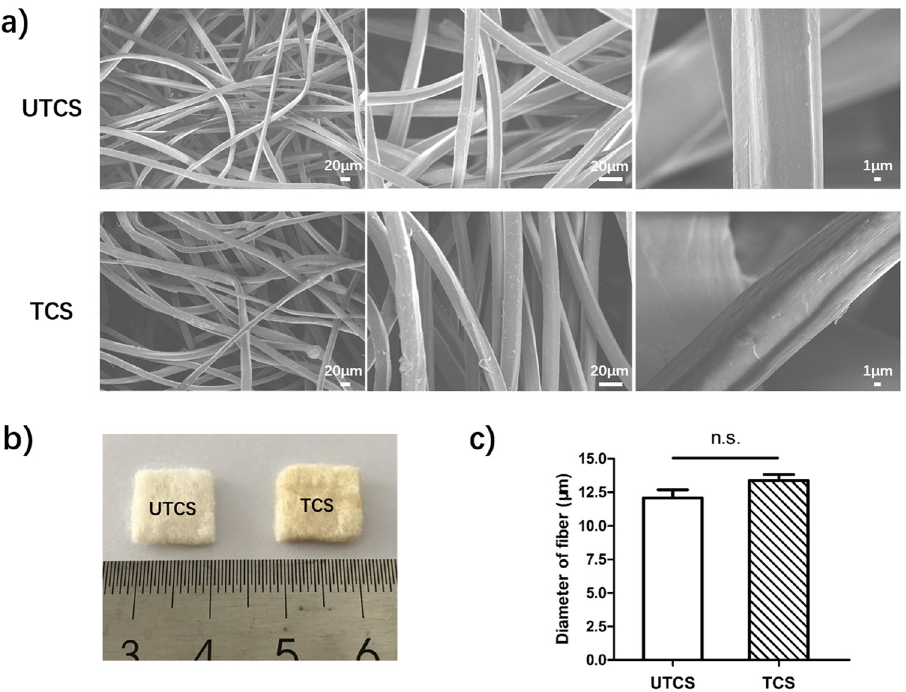
Figure 1: ( a ) Scanning electron micrograph of UTCS and TCS dressings; ( b ) macro photographs of UTCS and TCS dressings; ( c ) statistical analysis of the fi ber diameter of two groups ( n = 30 ) . All data were mean ± SEM. The di ff erences in each group were performed using two - tailed unpaired t - test. NS indicates P >